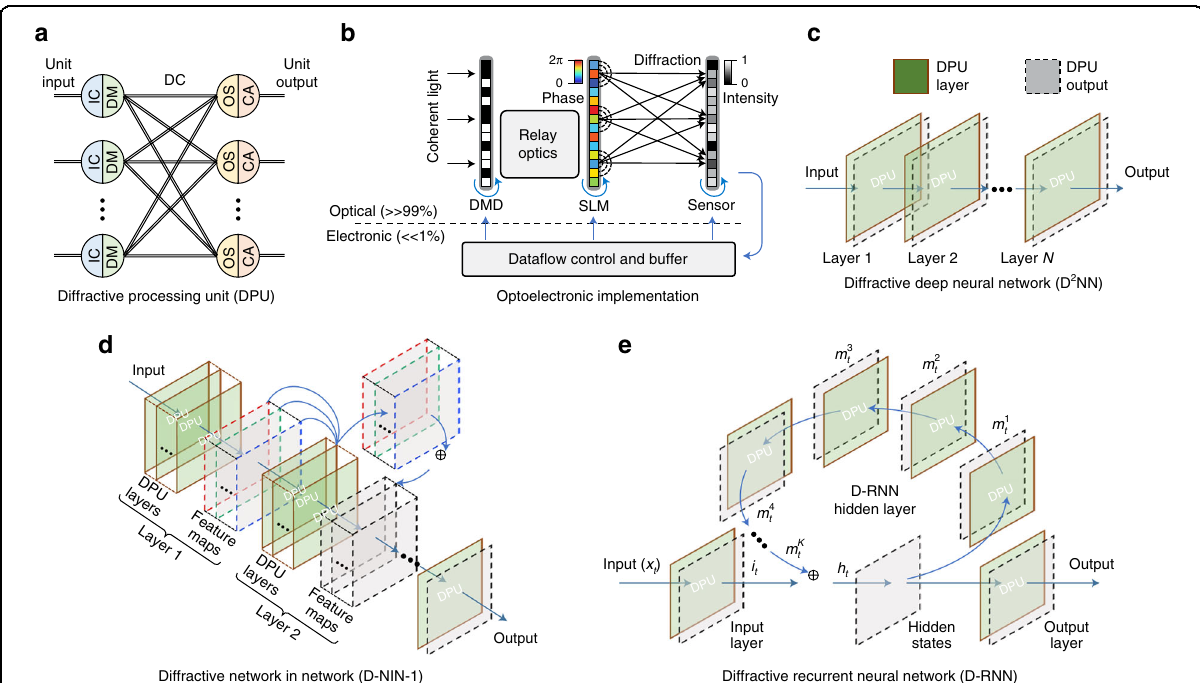
Fig. 9 Optoelectronic fused neural computing framework 58 . a DPU. b Programmable optoelectronic devices to implement the DPU. c – e Three different types of neural network architectures were constructed, including the D 2 NN, D-NIN-1, and D-RNN. a – e Reproduced from ref. 58 with permission of Springer Nature: Nature